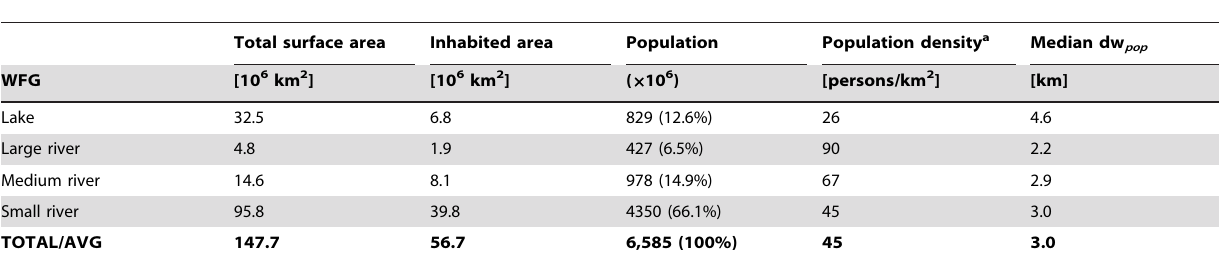
Table 3. Summary of the water feature groups (WFG) results (see also Supporting Information S2).